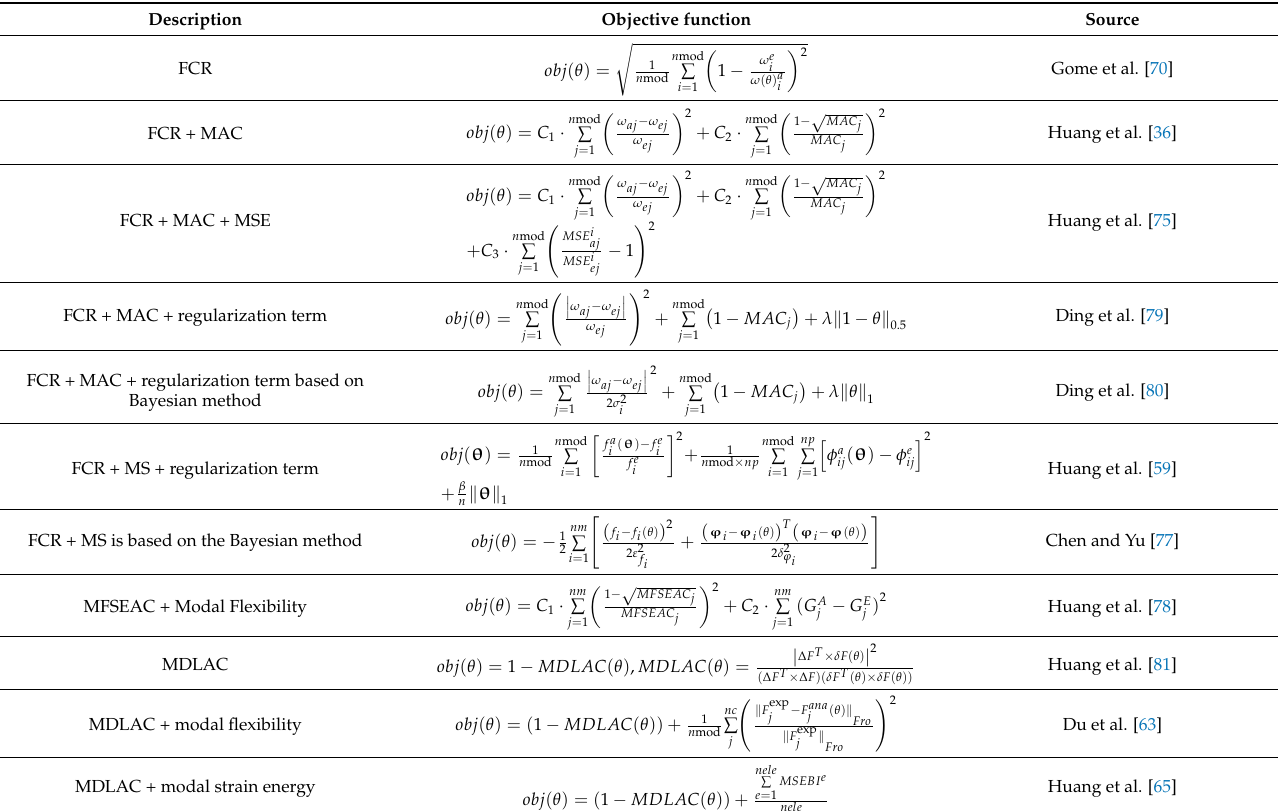
Table 2. The objective functions used in FEM-updating SDD